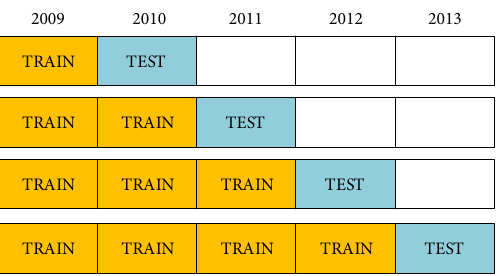
Table 4. The definitions and searching spaces of hyper-parameters for survival GBDT and SurvXGBoost Model Hyper-parameter Function Survival GBDT Number of iterations The number of iterations of boosting process